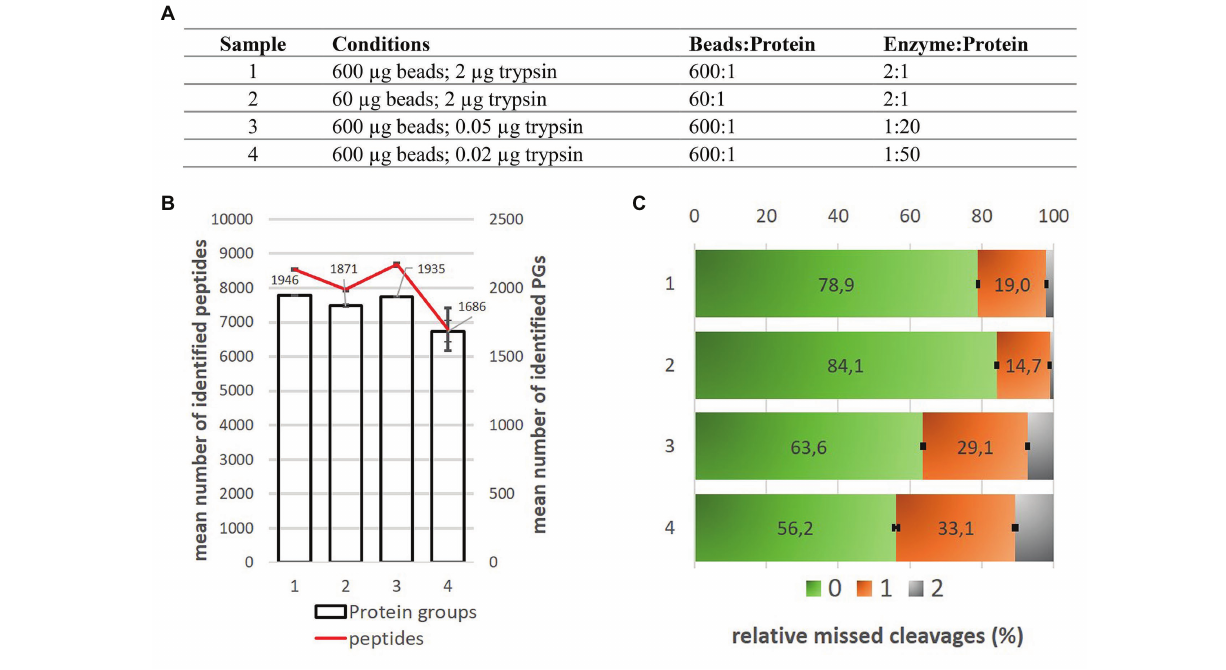
FIGURE 3 | Comparison of SP3 Carboxy method performance for 1 μ g input amount of Arabidopsis thaliana samples. (A) The overview of conditions applied in this experiment. (B) Mean number of protein groups and peptides identified under given conditions. Technical variability of protein groups and peptide detection is displayed as error bars for three replicates. (C) Relative missed cleavages content (%) corresponds to the number of identified peptides without any missed cleavage (green), with one (orange) and two (gray) missed cleavages. Data were calculated as an average value from three replicates. Standard deviation was applied for error bars